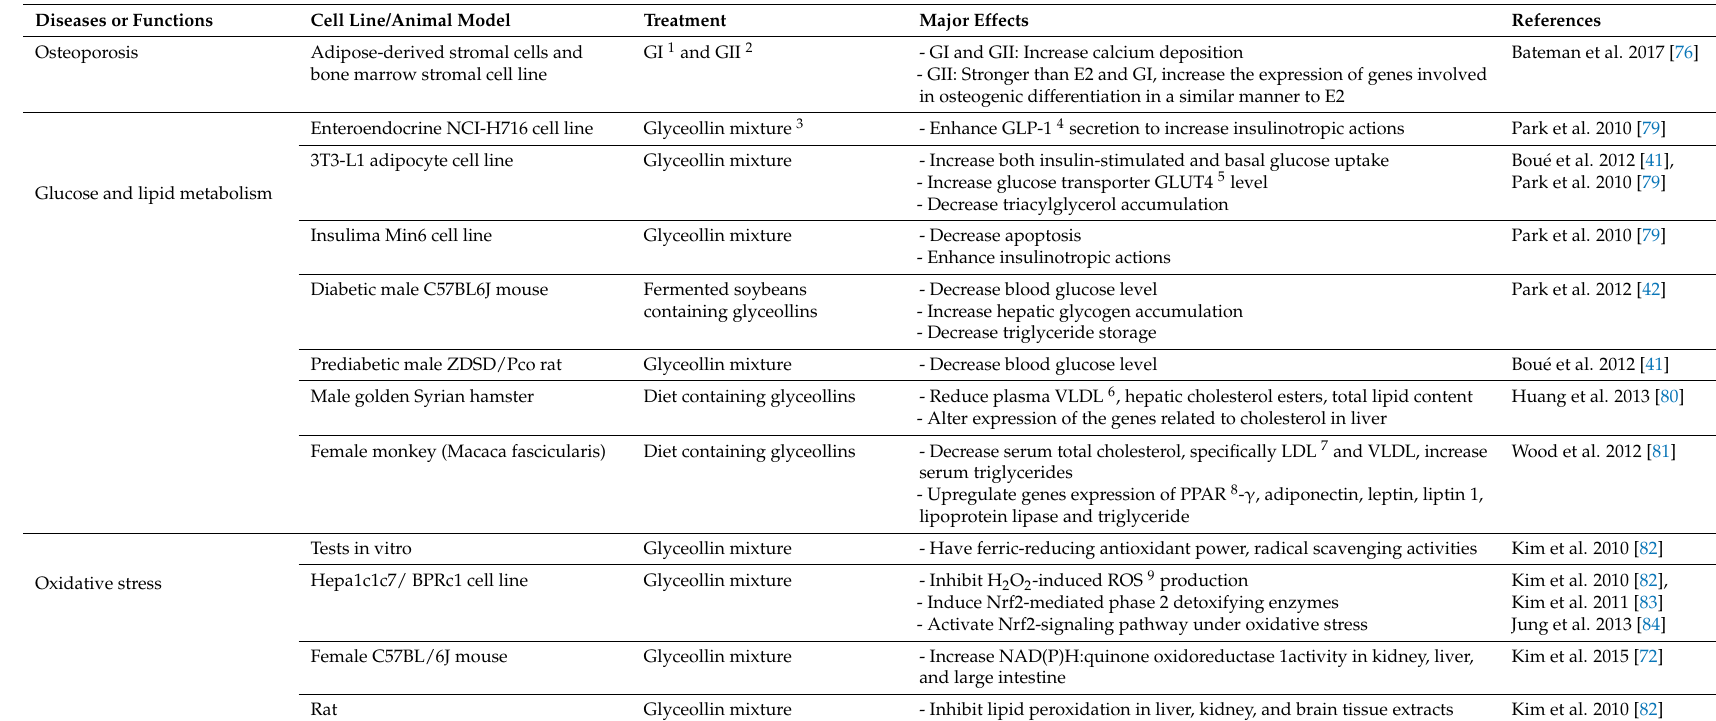
Table 2. Glyceollins effects in noncancer